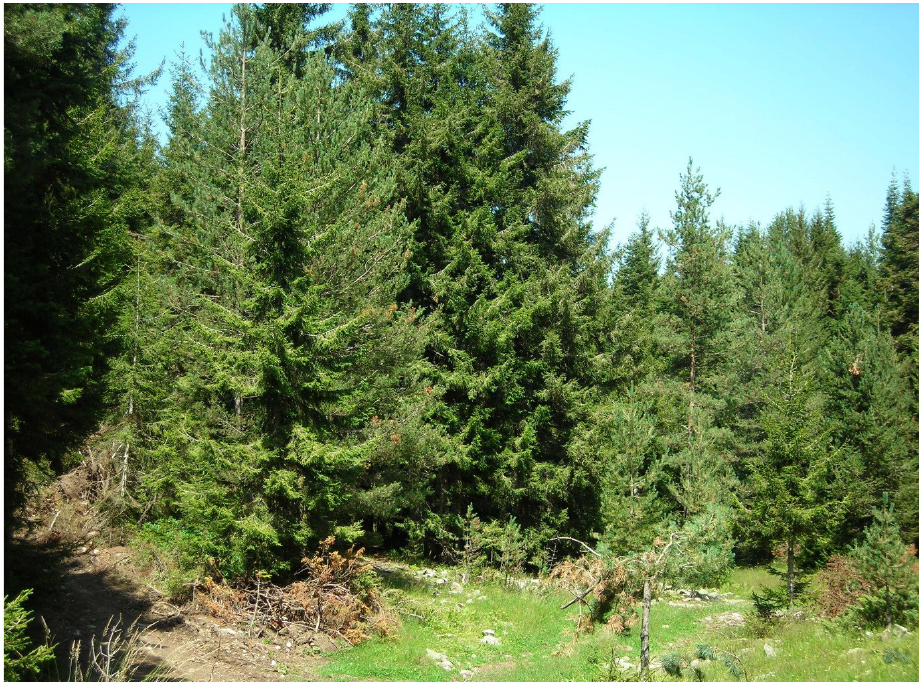
Fig 1 . Collecting site of Arsiyan Plateau, Turkey, where the inquiline ant Leptothorax kutteri was found in a nest of Leptothorax acervorum.